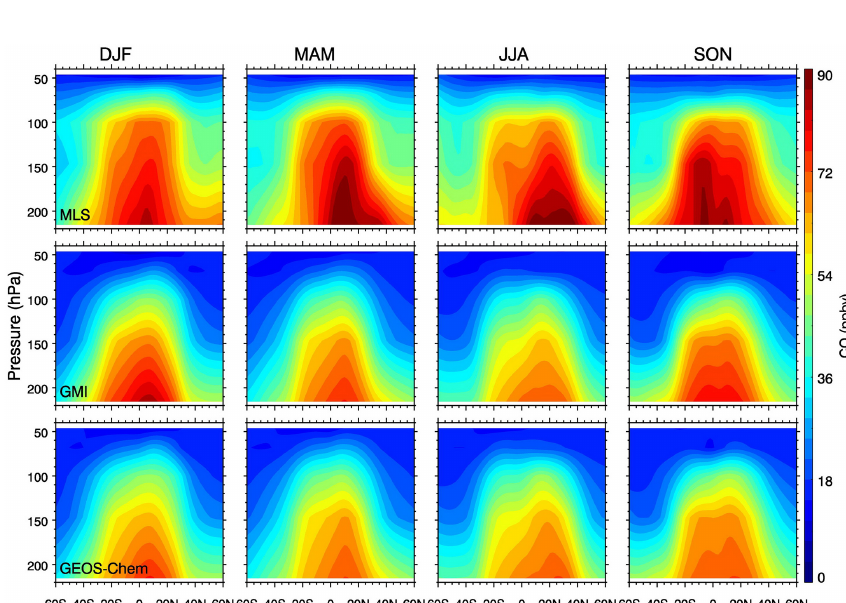
Figure 4. Vertical/latitudinal distribution of zonal mean CO mixing ratio during different seasons (DJF, MAM, JJA and SON) from (top row) MLS V4 data; (middle row) GMI model simulation with MLS AKs applied; (bottom row) GEOS-Chem model simulation with MLS AKs